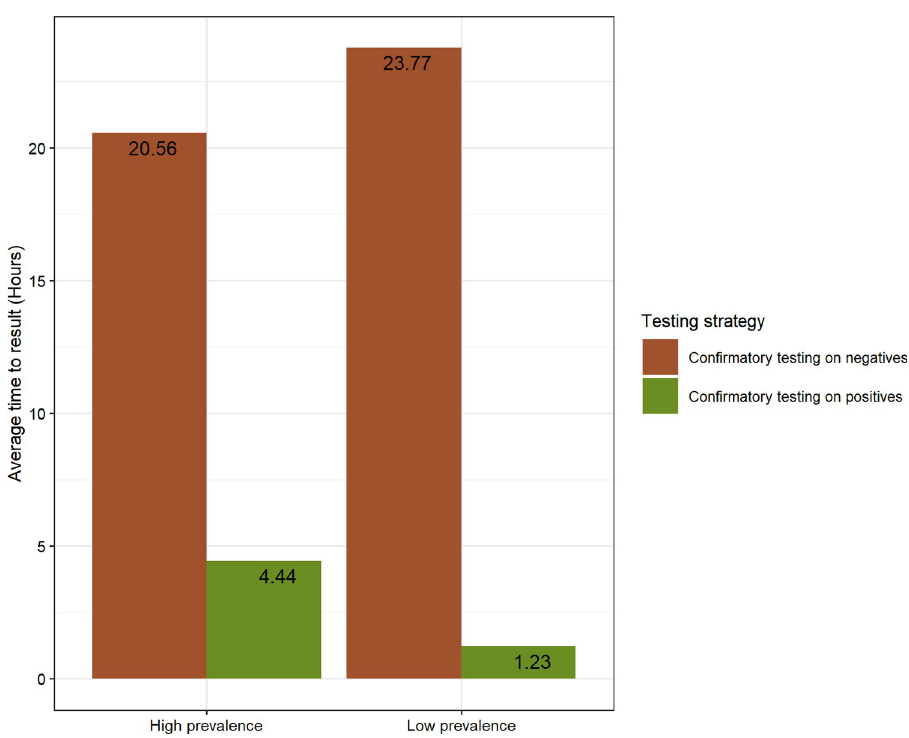
Fig 5. Average time taken to receive results (hours), based on assumed turnaround times of individual tests. The turnaround time for a testing strategy is the duration from sample collection to reporting of results to the patient from whom the samples were